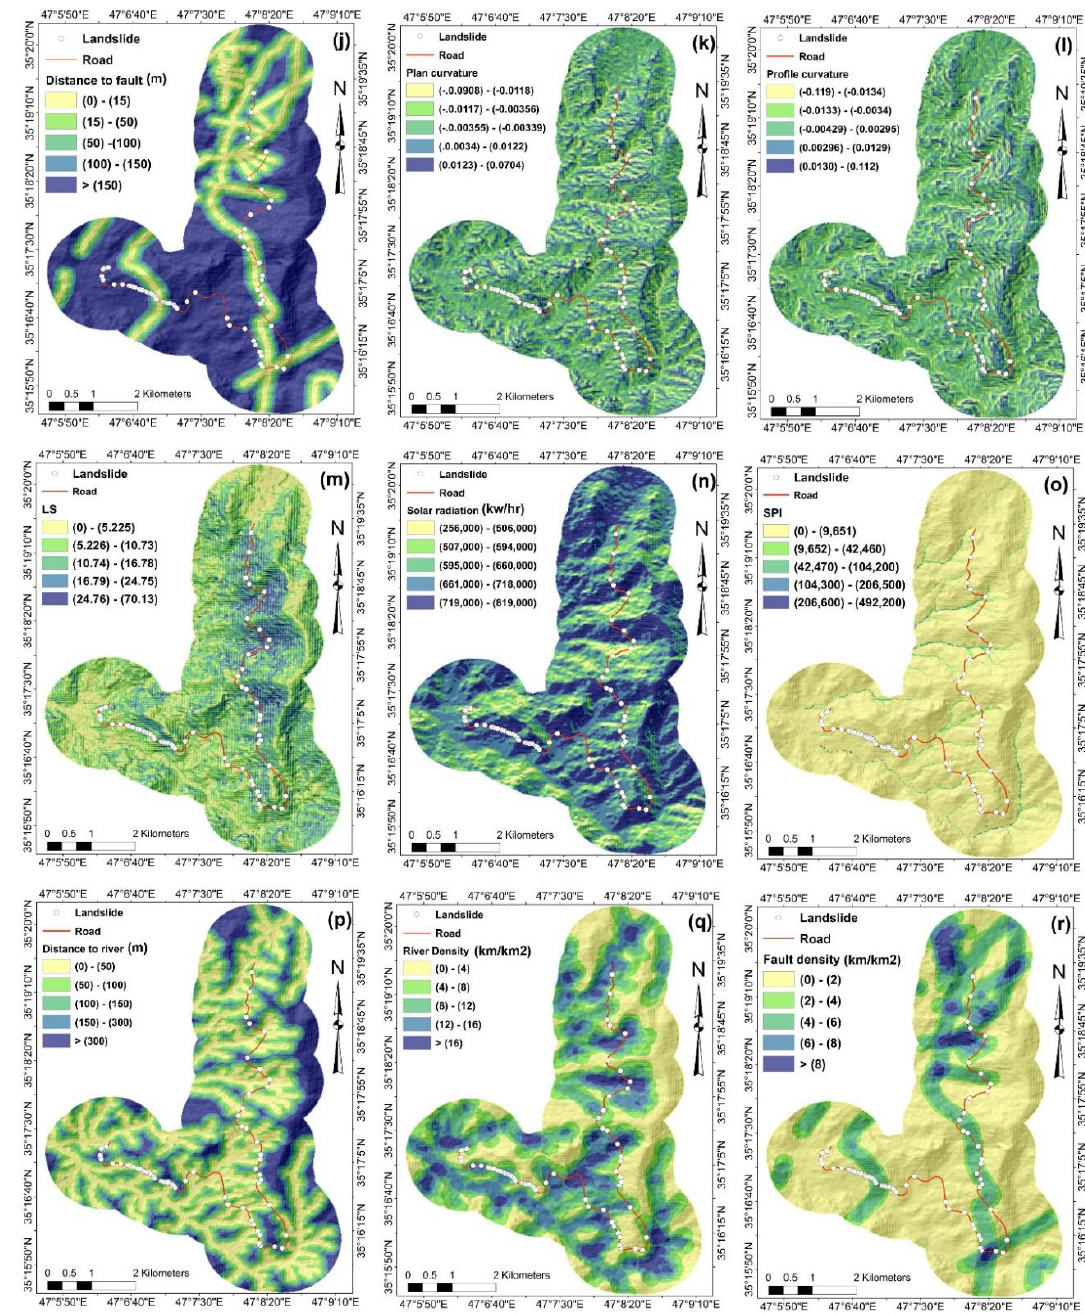
Figure 3. Spatial database for landslide susceptibility analysis: ( a ) slope, ( b ) aspect, ( c ) elevation, ( d ) distance to road, ( e ) TWI, ( f ) NDVI, ( g ) lithology, ( h ) land cover, ( i ) rainfall, ( j ) distance to fault, ( k ) plan curvature, ( l ) profile curvature, ( m ) LS, ( n ) solar radiation, ( o ) SPI, ( p ) distance to river, ( q ) river density, ( r ) fault density. Table 1. Lithological units and its description of the study area.